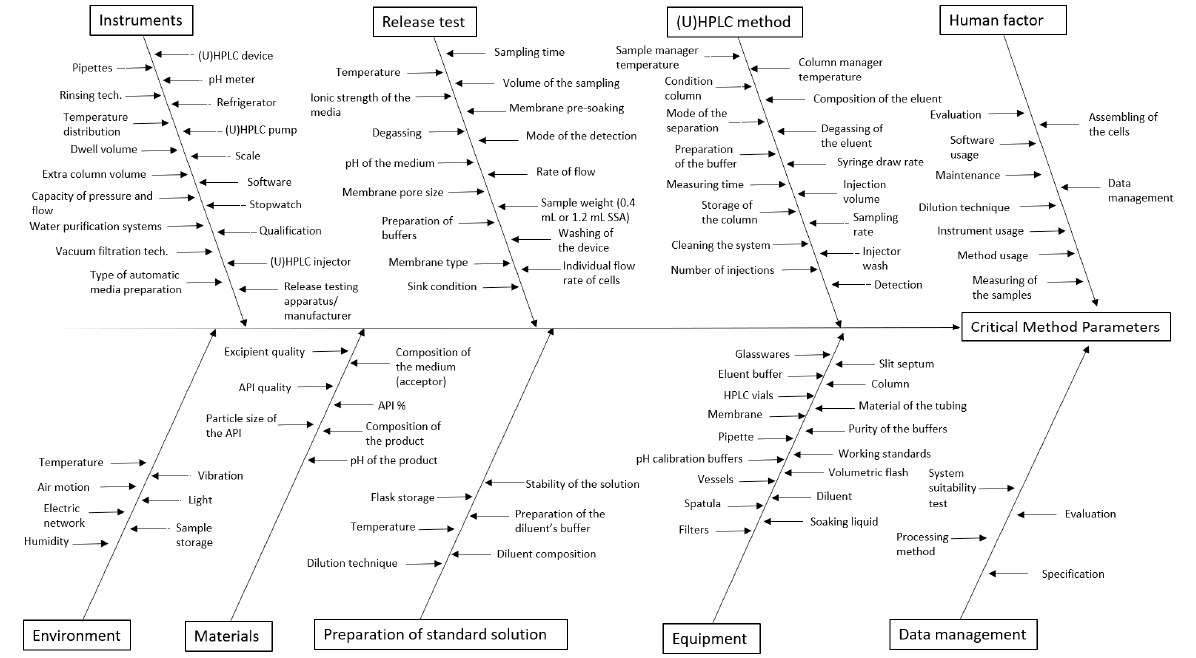
Figure 2. Ishikawa diagram illustrating method parameters that may have an impact on the method attributes.